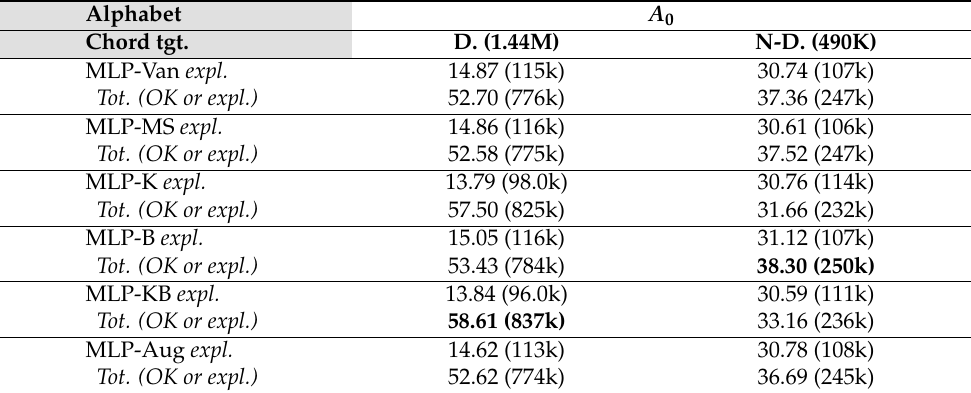
Table 10. For each model: the first line corresponds to the percentage of errors explained by substitu- tion on diatonic (D.) and non-diatonic (N-D.) chord targets, the second line is the total percentage of correct prediction and explainable errors. The amounts of associated items in the test dataset are in